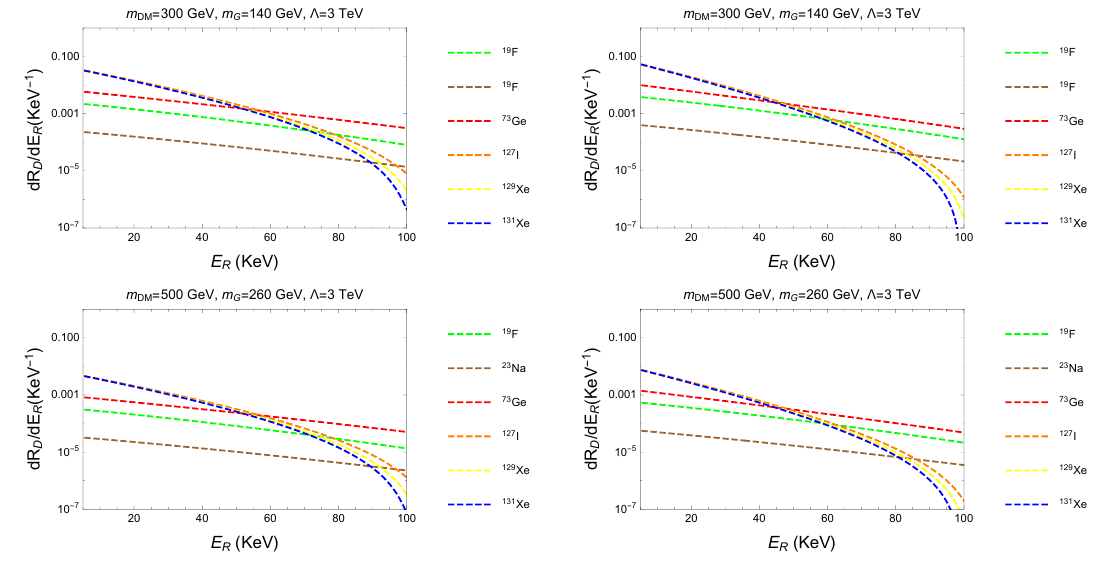
Figure 3 . The same as in (cid:12)gure 2, but with di(cid:11)erent masses for DM and spin-2 mediators and (cid:3) = 3